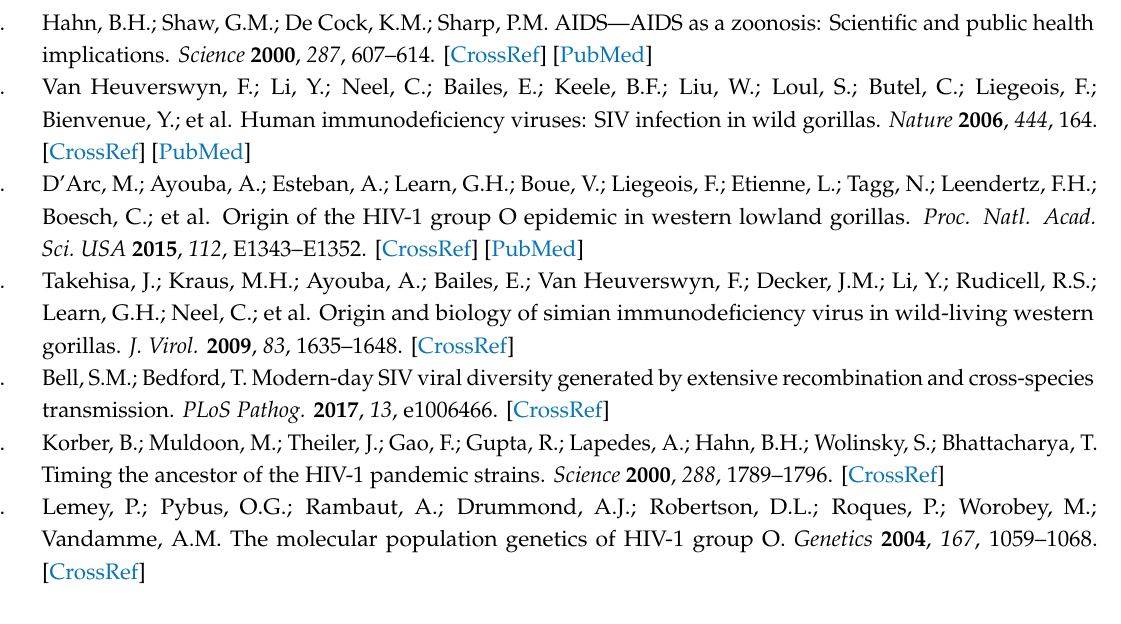
Figure S1: Residues distribution for Gag30 along the HIV-1 / SIV phylogeny. This position exhibits a pattern more similar to “content shift” than to “rate shift”, Table S1: Maximum log-likelihood (LL) values for the analysis of the nine HIV-1 / SIVcpz / SIVgor proteins under the rate shift and null models, Table S2: Rate shifts as percentage from total rate shifts for prominent branches, for rate decelerating sites (upper) and rate accelerating sites (lower), colored by intensity. Data presented in this table is not normalized by protein length, Table S3: Rate deceleration events that may be related to previously reported species-specific adaptation events, File S1: Phylogenetic tree and sequence alignments used for identifying rate shifting sites. The zip file contains all nine alignments and constructed phylogeny used for identifying rate shifting sites, File S2: HIV / SIV sites identified as rate shifting. Positions are provided in HXB2 reference sequence coordinates. Branch number field refer to the branch number outputted by RASER (Penn et al. 2008); for ease of reading we provide branch labels for most branches, File S3: HIV / SIV sites identified as rate shifting when group M contains many more sequenced than group O. Positions are provided in HXB2 reference sequence coordinates. Branch number field refer to the branch number outputted by RASER (Penn et al. 2008); for ease of reading we provide branch labels for most